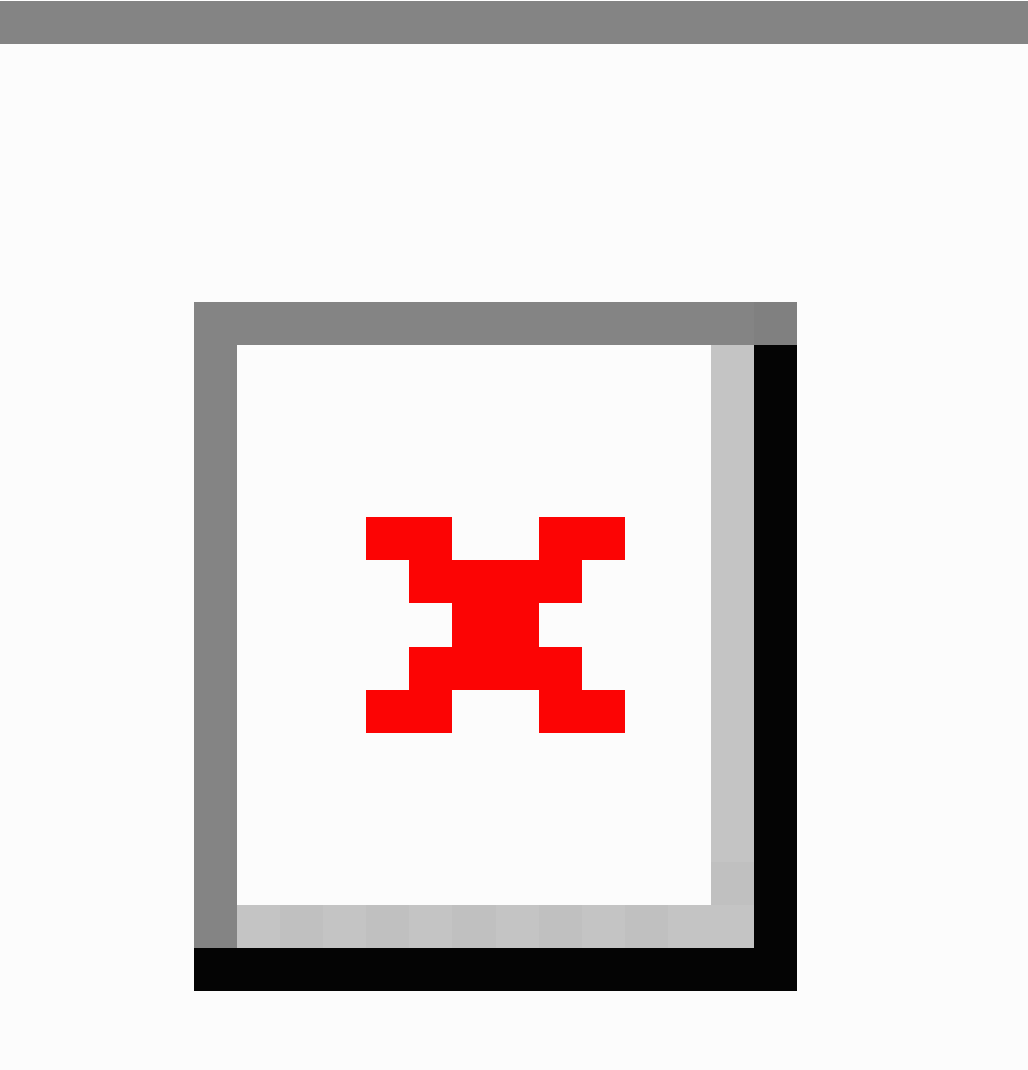
Figure 2. DistractMe provides tips to cope with cravings with the option to add a comment. The red circle in the navigation bar highlights notifications of responses from other